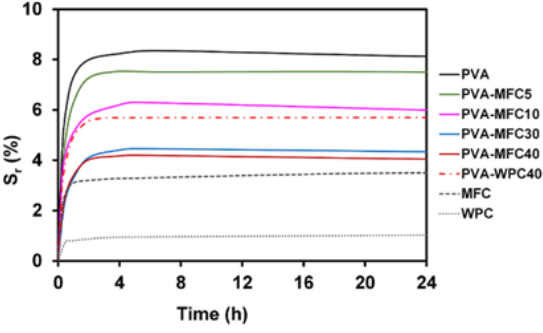
Figure 8. Swelling ratio of PVA-based foams.